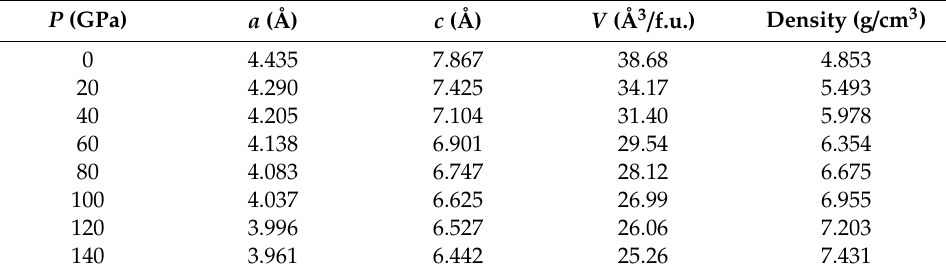
Table 2. Lattice parameters of tetragonal FeF 3 from first-principles